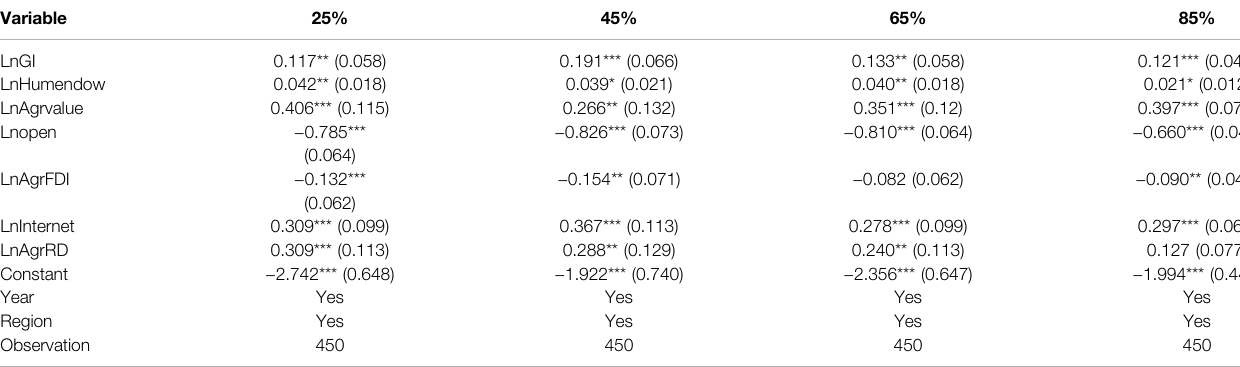
TABLE 3 | Quantile regression of the impact of GIC on the technical complexity of export agricultural products. Variable